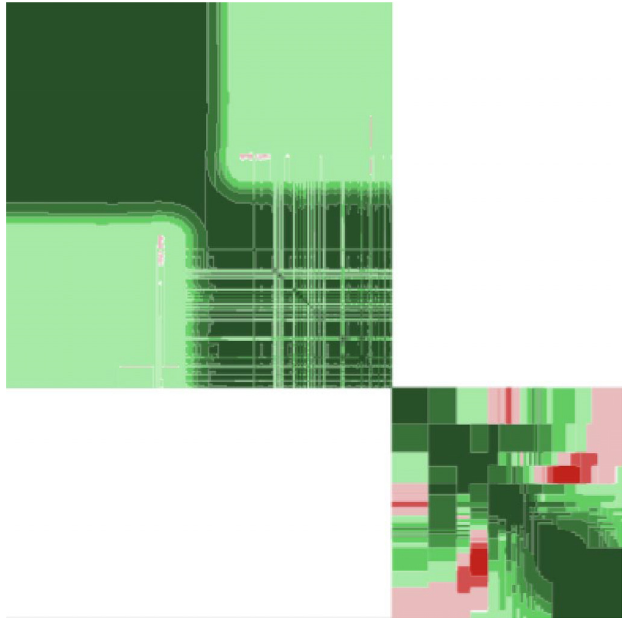
Fig. 4. The correlation matrix evaluated for 239 Pu ( n , g ) in ENDF/B-VII.1 shows two uncorrelated blocks for two energy regions, meeting at 2.5 keV, the upper limit of the unresolved resonance